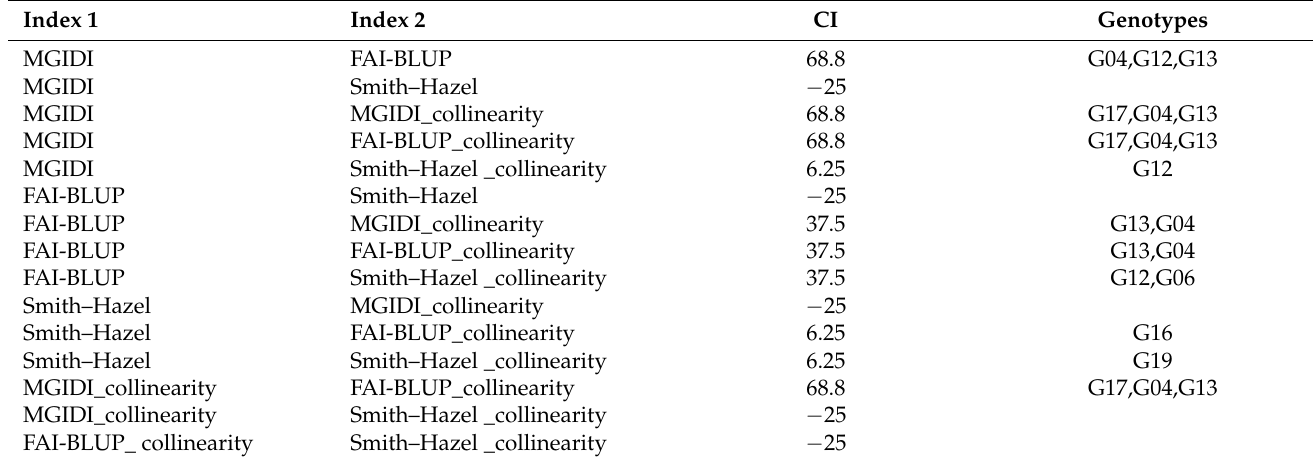
Table 4. Coincidence index (CI) of genotype selection for each pair of indices evaluated.